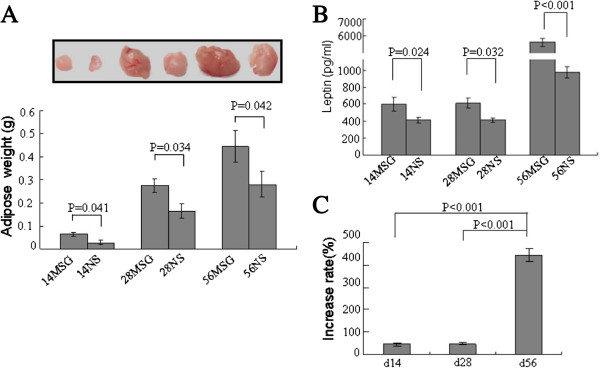
MSG ip increased the weight of body fat and induced hyperleptinemia. MSG or NS treatments were performed using intraperitoneal injections (ip) in mice from the first postnatal day (d0) to 14 days, who were called 14MSG or 14NS mice; to 28 days, who were called 28MSG or 28NS mice; or to 56 days, who were called 56MSG or 56NS mice. These selected times are representative of prepuberty, puberty and adulthood, respectively. The epididymal adipose was obtained from each MSG and NS-treated group (A). The leptin levels in the plasma of MSG or NS- treated mice (B). The rate of increased leptin level was assessed using MSG-treated mice compared with the corresponding NS-treated mice and dividing by the leptin concentration of NS-treated mice (C).